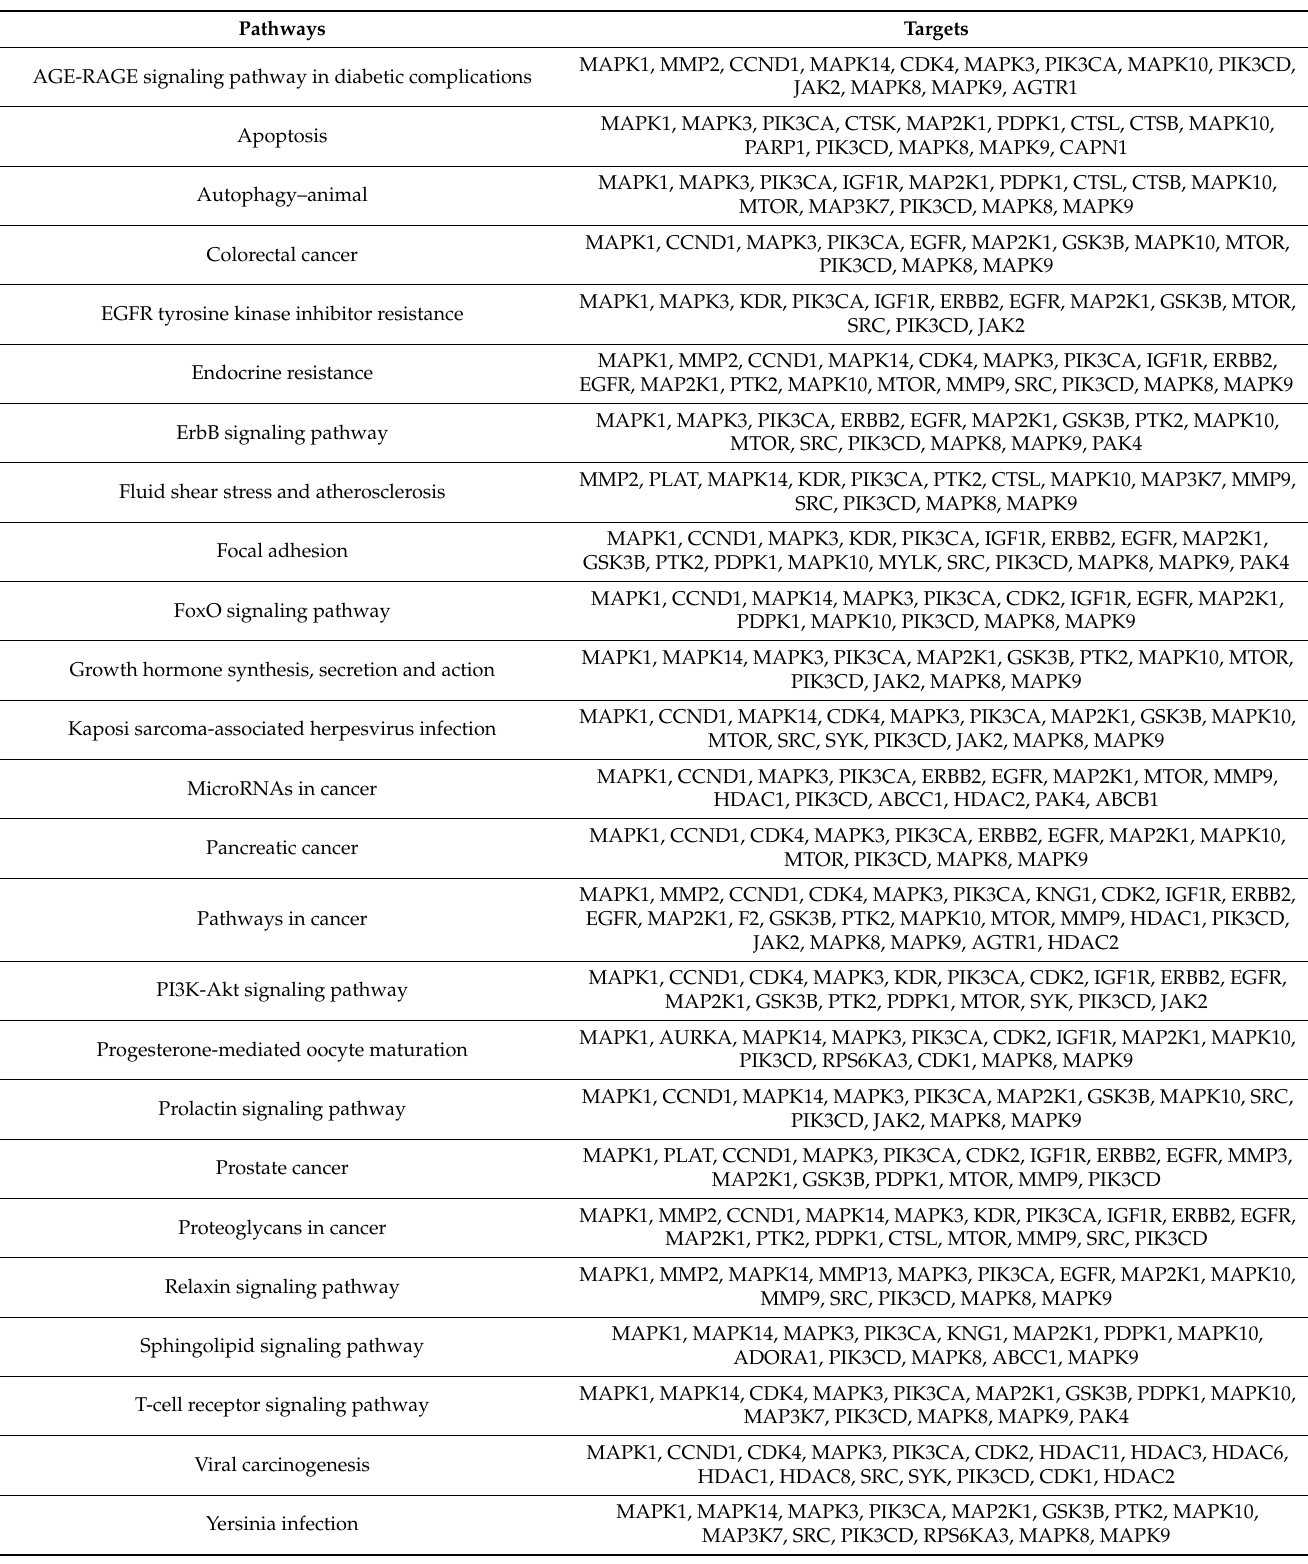
Table 1. Pathways related to 22-(4 (cid:48) py)-JA against